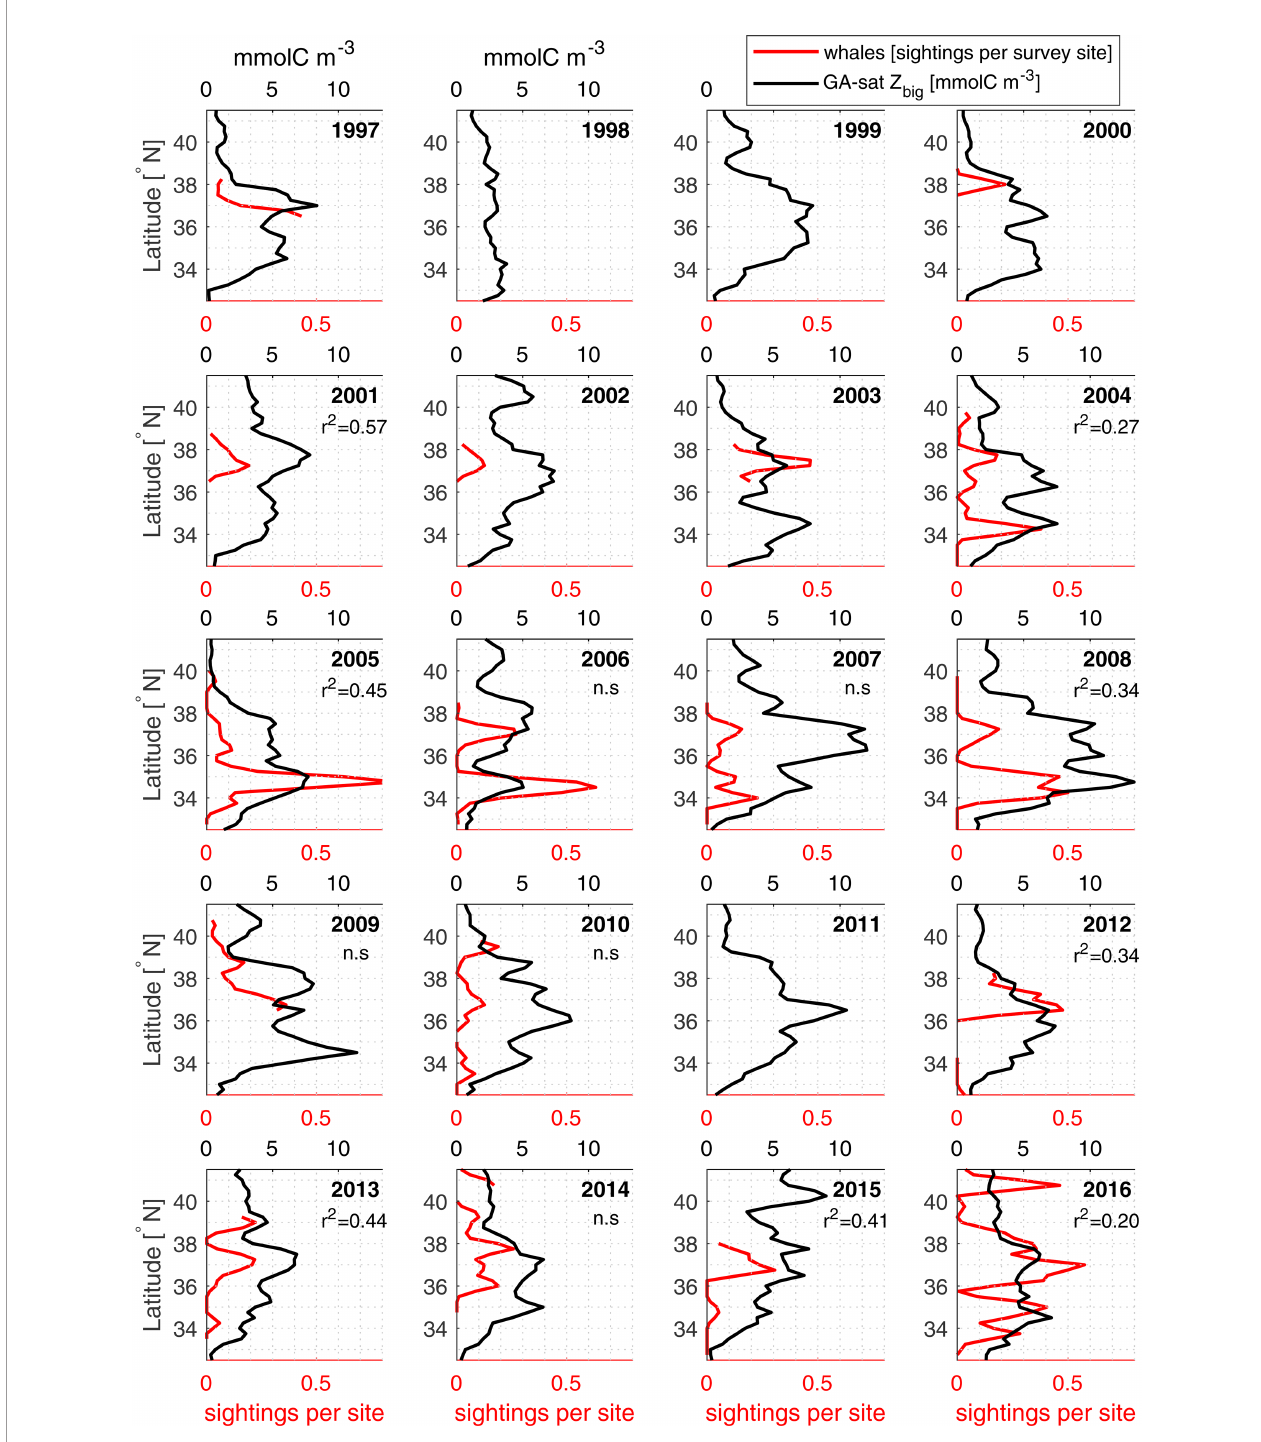
FIGURE 11 | Comparison of GA-sat output and humpback whale sightings. Yearly latitudinal pro fi les comparing humpback whale sightings from RREAS divided by total sites surveyed (red) against GA-sat Z big (black). Whale surveys occurred predominantly in May (74% of samples) but also include sightings from late April (9%) and early June (17%). GA-sat Z big was averaged within 150 km from shore during the month of May. Correlation squared are reported when whale sightings are available over at least 2° latitude; n.s. indicates non-signi fi cant correlations (p > 0.05). As explained in text, a direct correspondence is not